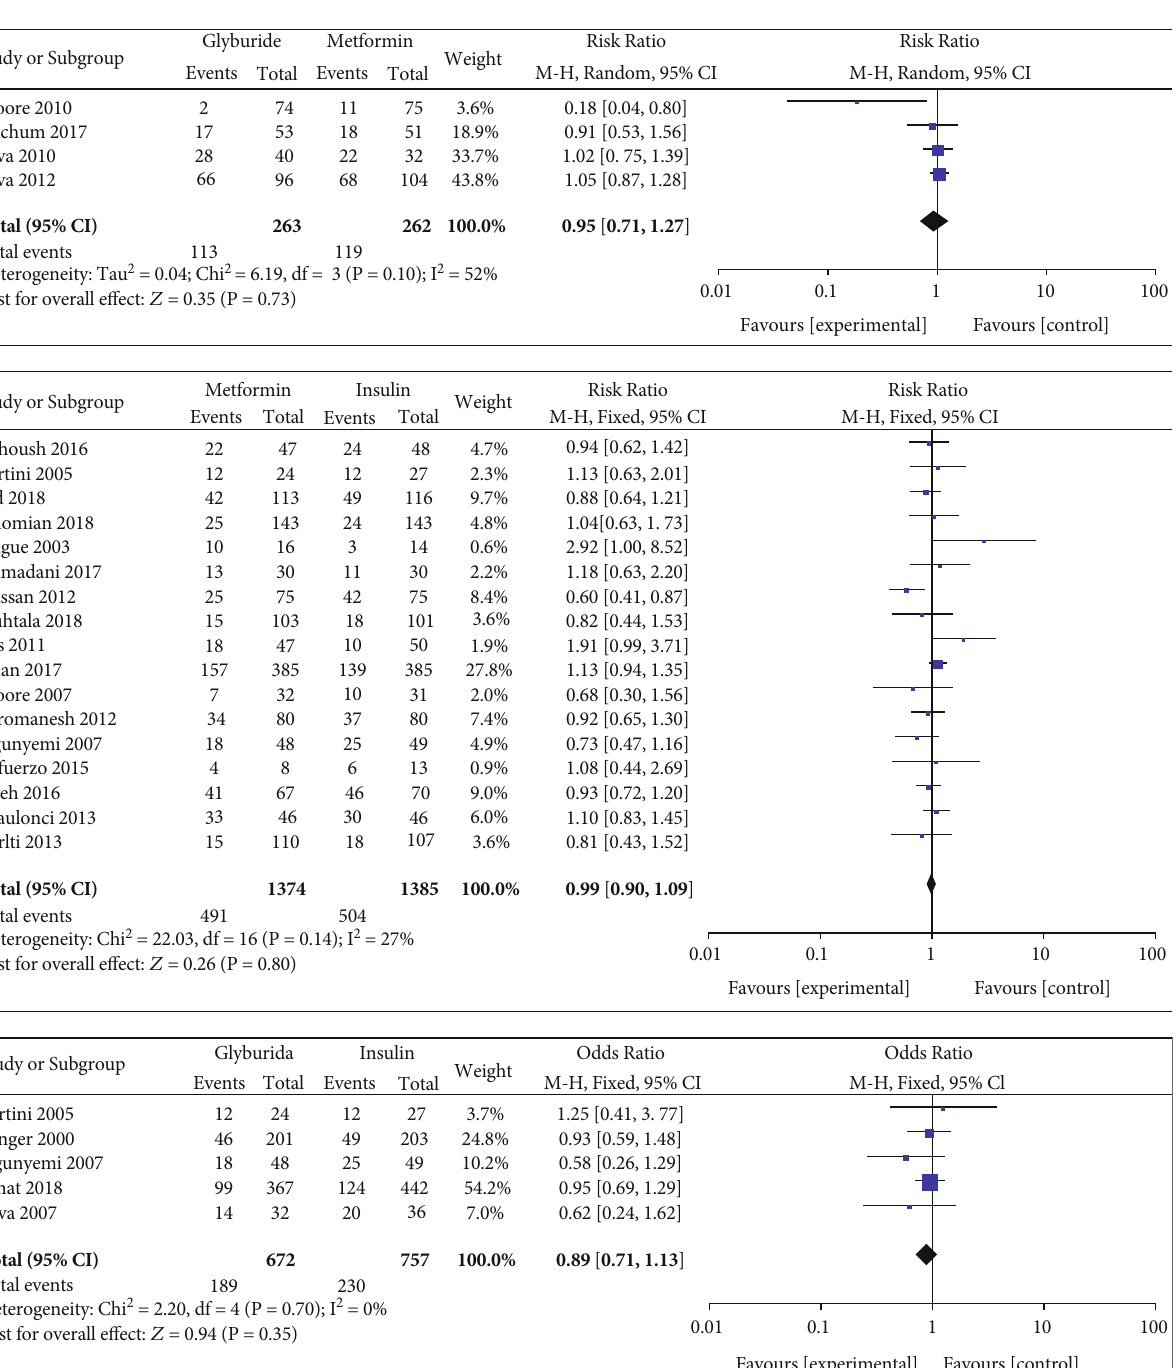
Figure 8: Cesarean